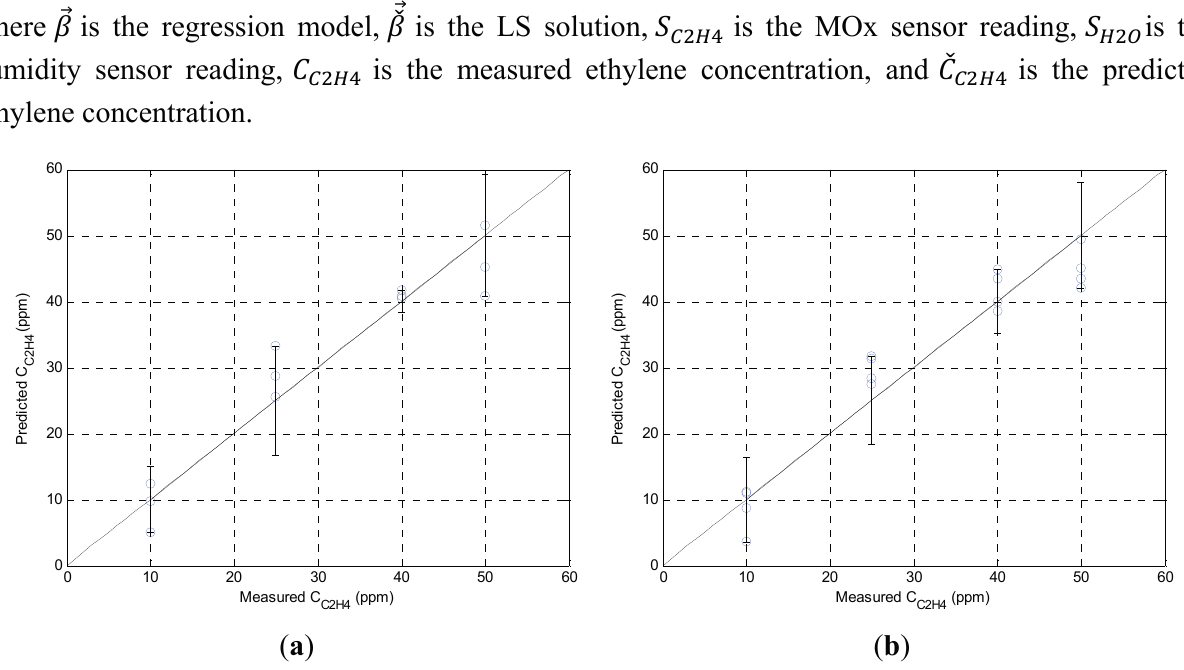
Figure 5. The combined prediction model as a linear function of the ethylene concentration, relative humidity, and their product for the ( a ) MQ-3 and ( b ) MiCS-5914